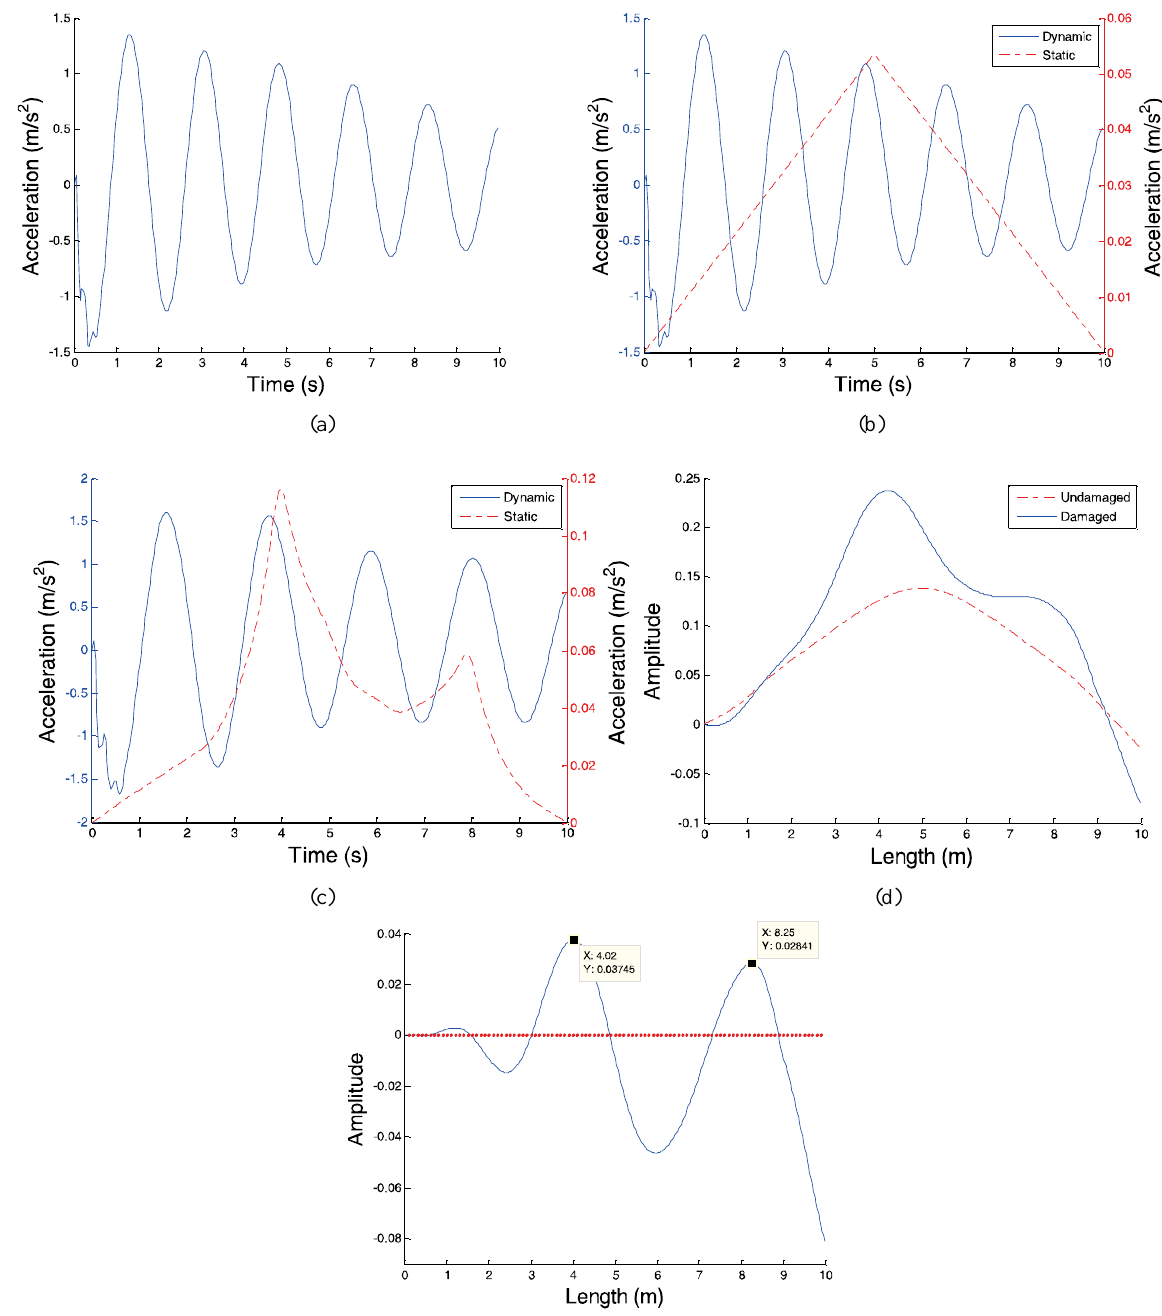
Fig. 4. (a) total mid-span acceleration of a healthy beam due to a load travelling at 30 m/s; (b) static and dynamic components of acceleration from Fig. 4a; (c) static and dynamic components of acceleration from Fig. 3c; (d) total healthy and total damaged accelerations after MAF is applied; (e) IMF1 of damaged acceleration from Fig.